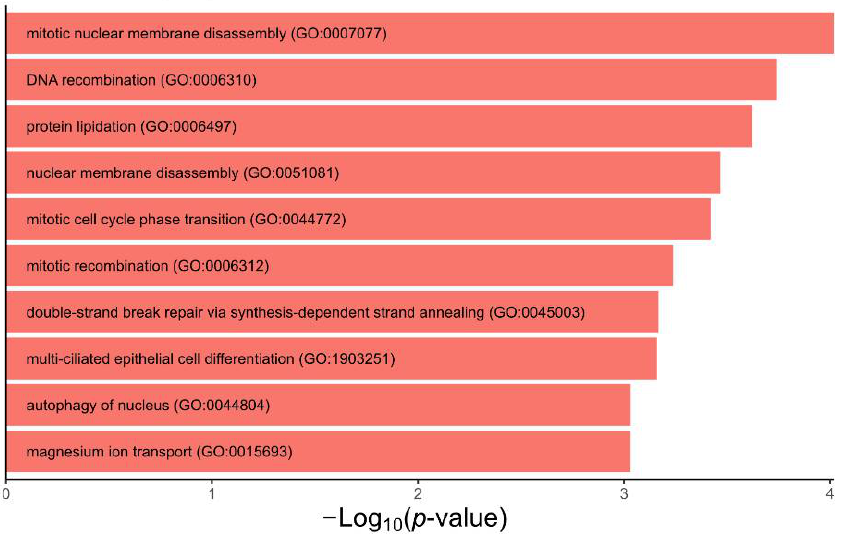
Figure A3. Top 10 most significantly enriched biological process GO terms associated with the genes exclusively differentially expressed in ( A ) PR8M infected cells, ( B ) SC35M infected cells, ( C ) SC35MΔNS1 infected cells. The terms are ranked according to the p -value.